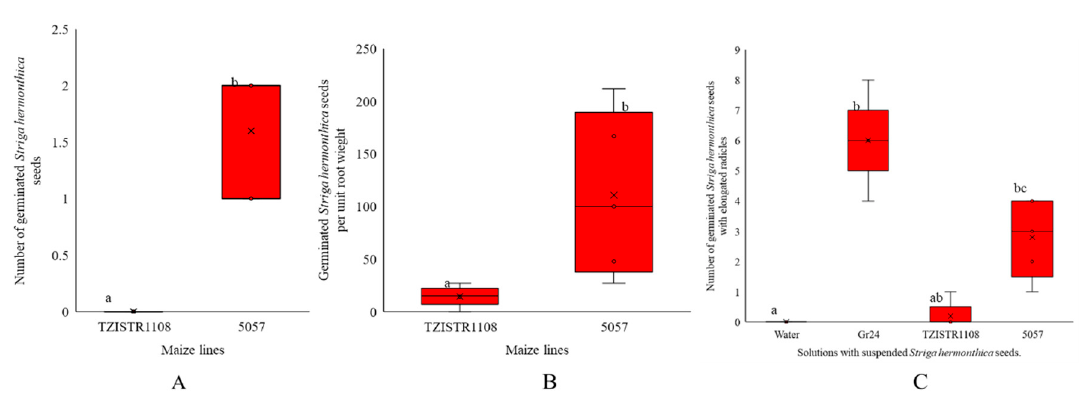
Figure 2. Maize root exudate S. hermonthica germination ability. Boxplots of ( A ) number of Striga hermonthica seeds germinated by the root exudates of the two lines after 72 h. ( B ). number of Striga hermonthica seeds germinated per unit root weight of both lines. ( C ) number of Striga hermonthica seeds with elongated radicles on suspension in the root exudates of the two varieties GR24 and water for 11 days. The letters in the figure show significant differences at α = 0.05.